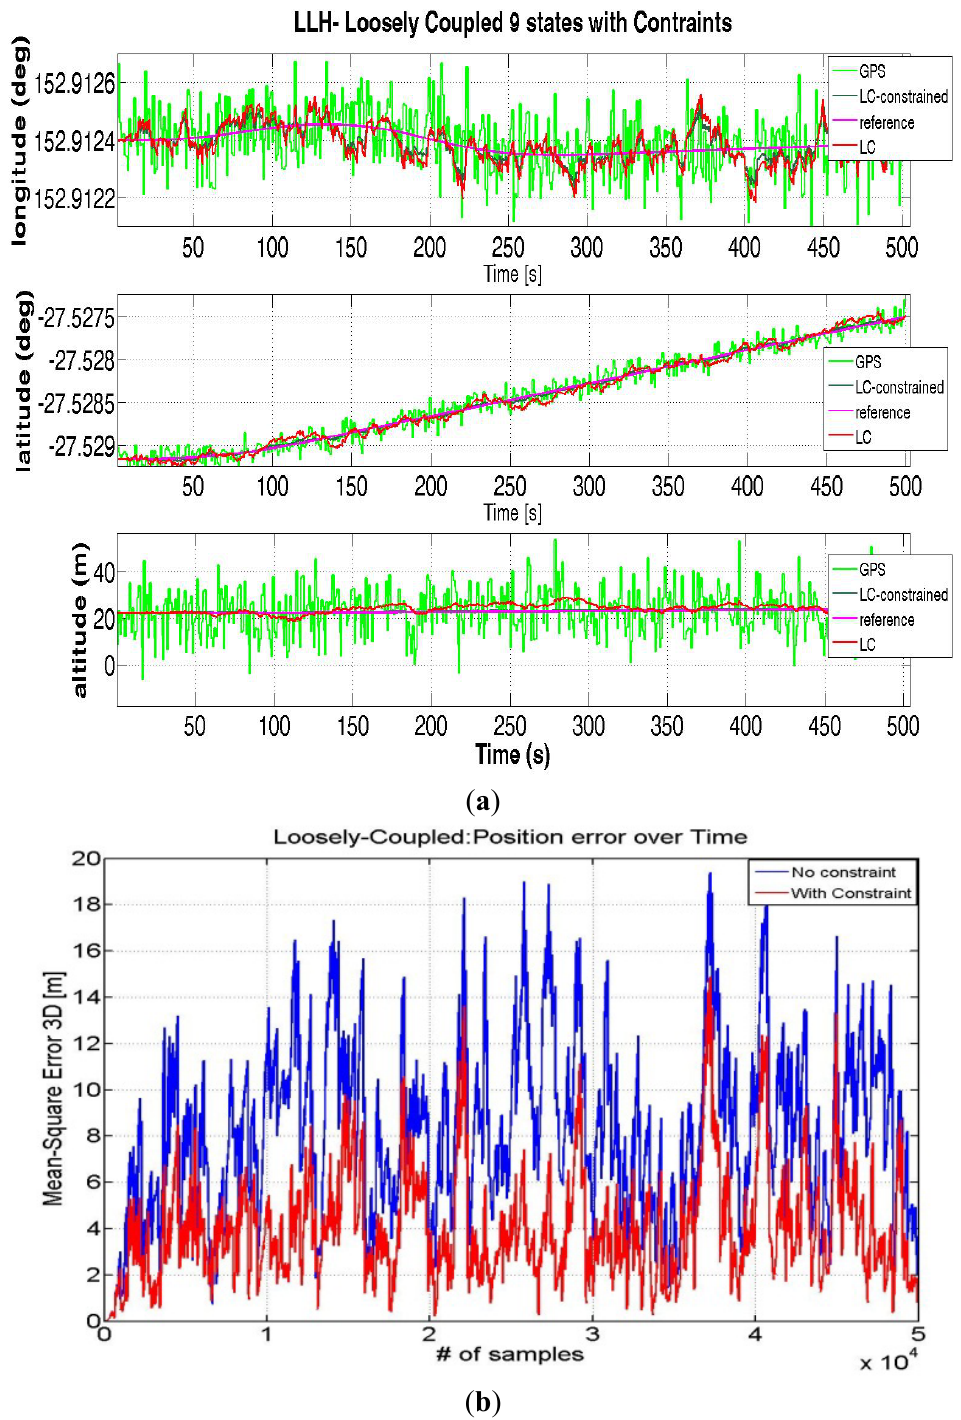
Figure 9. LC with and without constraints ( a ) and Trend of error 3D ( b